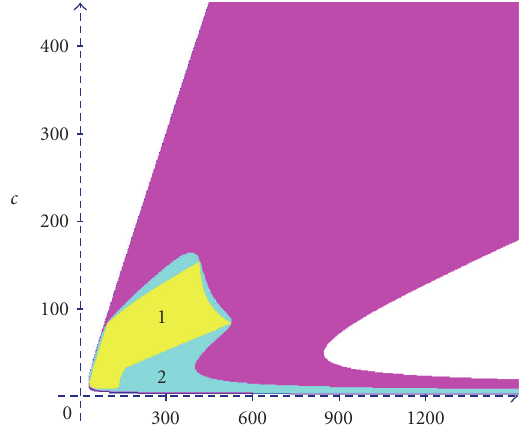
Figure 5.5 . Regions of su ffi cient stability condition and necessary and su ffi cient stability condition for (5.2): p = 12, h = 0 . 024, Δ = 0 .